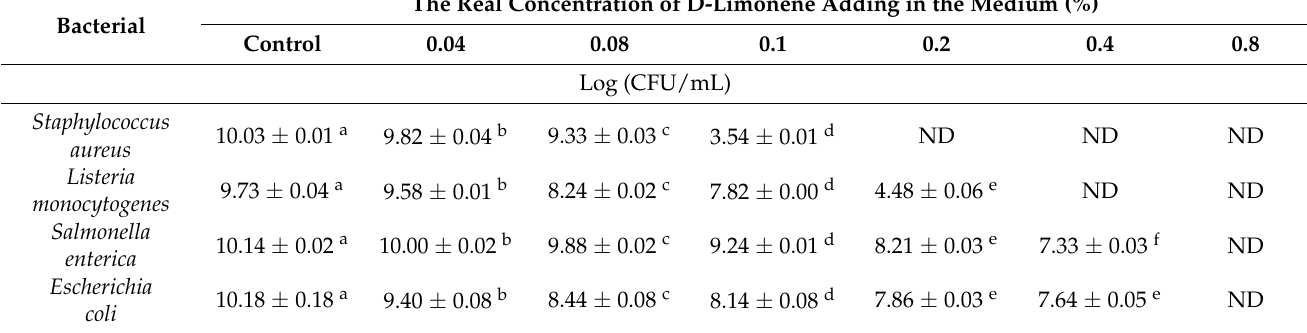
Table 1. Determination of the antibacterial activity of D-limonene solution against food-borne pathogens using broth dilution